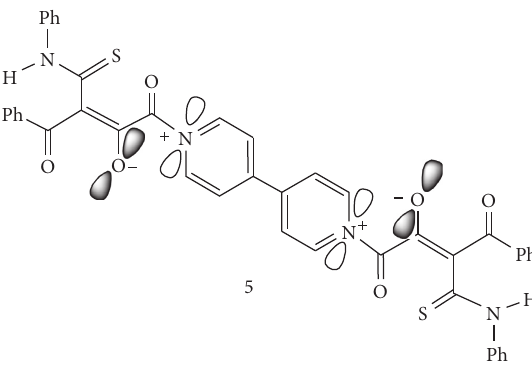
Figure 1: Overlapping between π -positive nitrogen orbital with π -negative oxygen orbital of 5